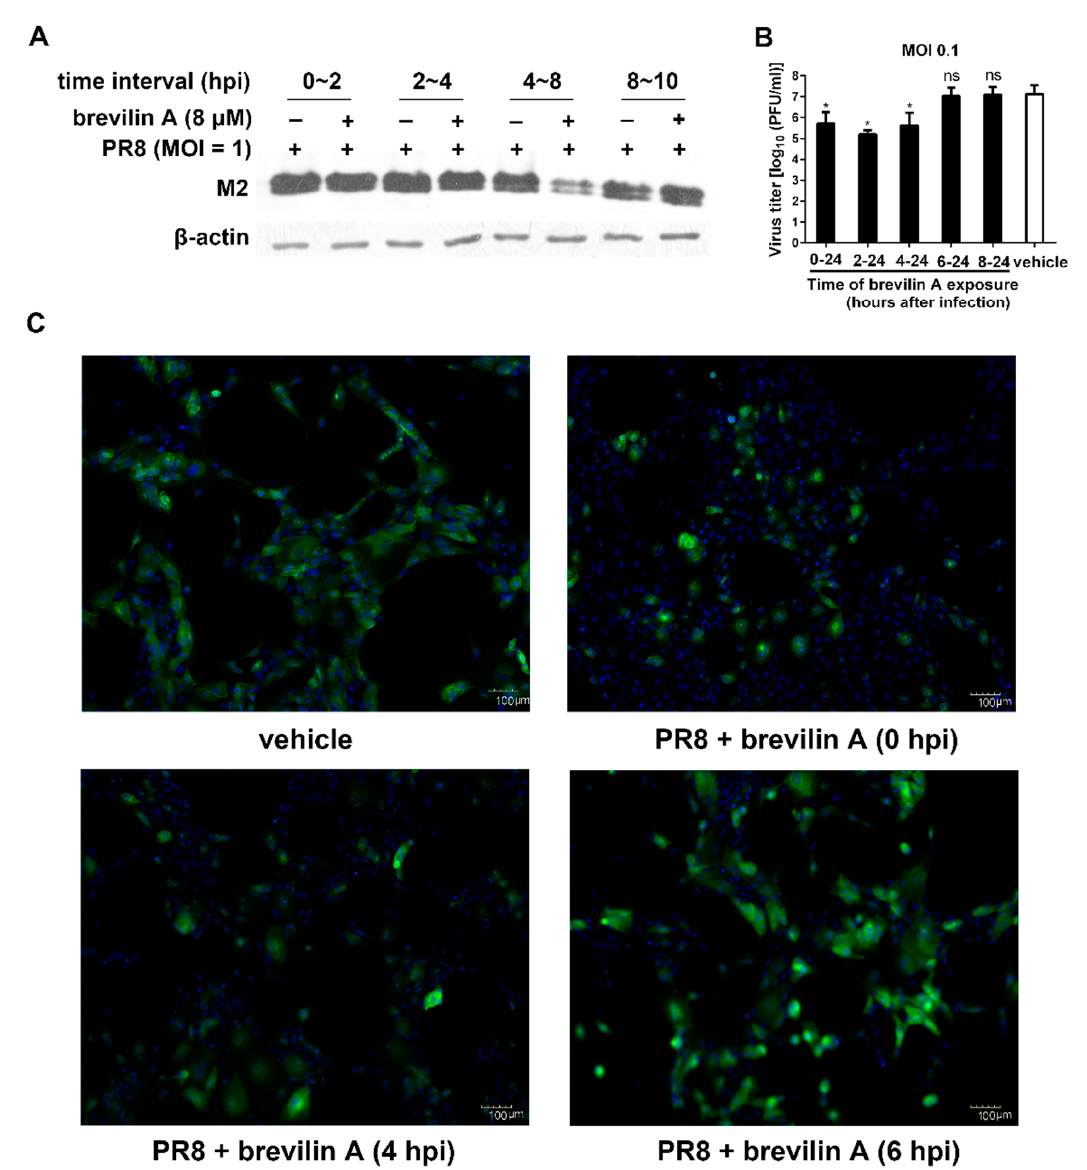
Figure 3. Influence of different treatment conditions of brevilin A on IAV replication. ( A ) MDCK cells were infected with PR8 at a MOI of 1, brevilin A or vehicle was present at four time-intervals, 0–2, 2–4, 4–8, and 8–10 hpi. At 12 hpi, cell lysates were analyzed by Western blot assay; ( B ) MDCK cells were infected with PR8 at a MOI of 0.1, then treated with brevilin A (8 µM) at 0, 2, 4, or 6 hpi. The virus titers in the supernatant were determined by plaque assay at 24 hpi; ( C ) MDCK cells infected with PR8 (MOI = 1) were treated with brevilin A at the indicated times. The M2 protein expression was determined by immunofluorescence assay at 12 hpi. The scale bar in the images is 100 µ m. The data represent means ± SD. *, p < 0.05 is considered statistically significant compared to vehicle.